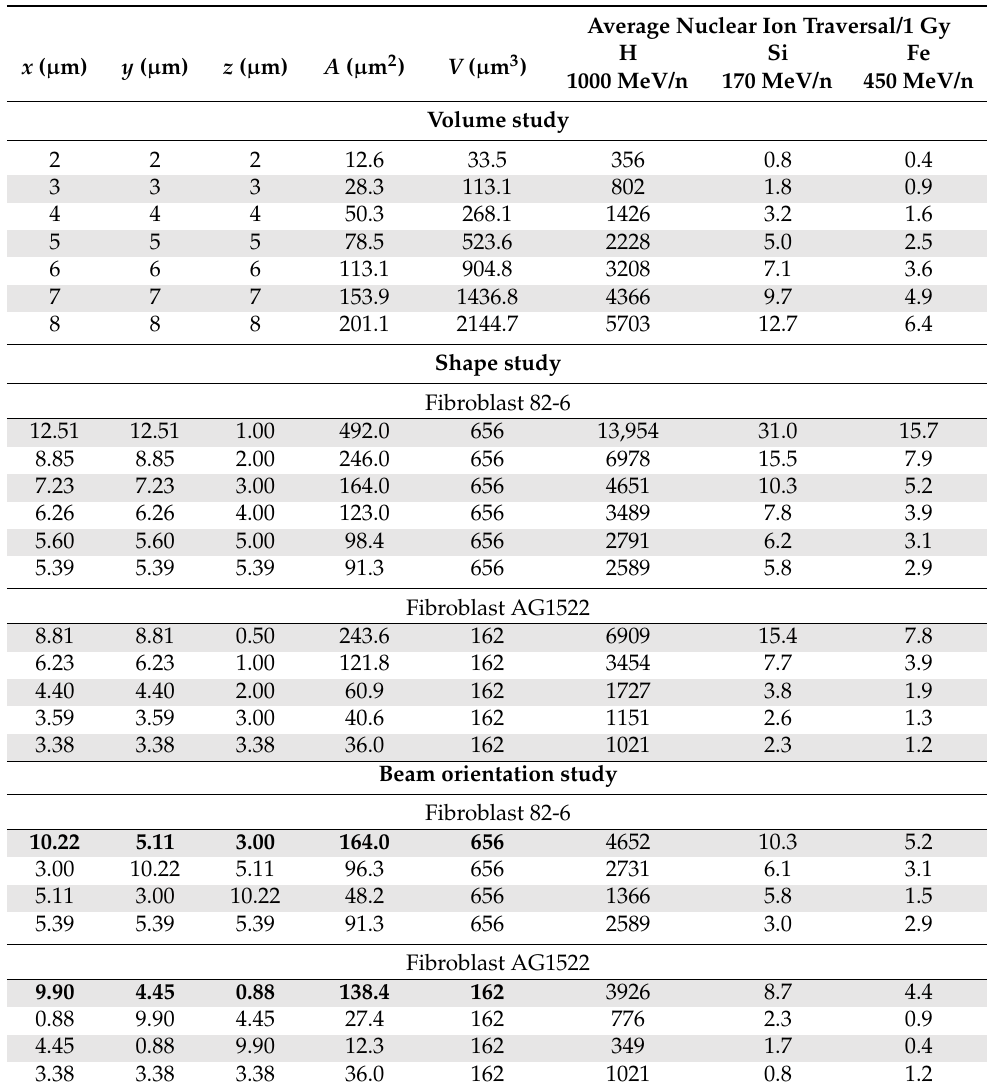
Table 1. List of nuclear geometries considered in this work. x , y and z represent the semi-axes of the nucleus (spherical or ellipsoidal). The beam is oriented along R z . A represents the irradiated surface, and V is the volume of the nucleus. The sizes in bold represent experimental AG1522 [32] and 82-6 fibroblast sizes